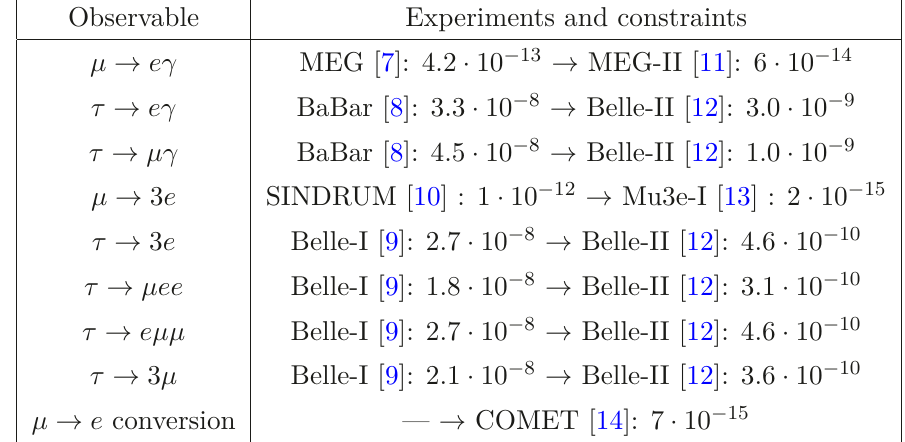
Table 1. Current and planned experimental bounds, related to corresponding observables. Data for τ decays for Belle-II was obtained from the figure 189 of ref. [12]. For the µ consider the Al